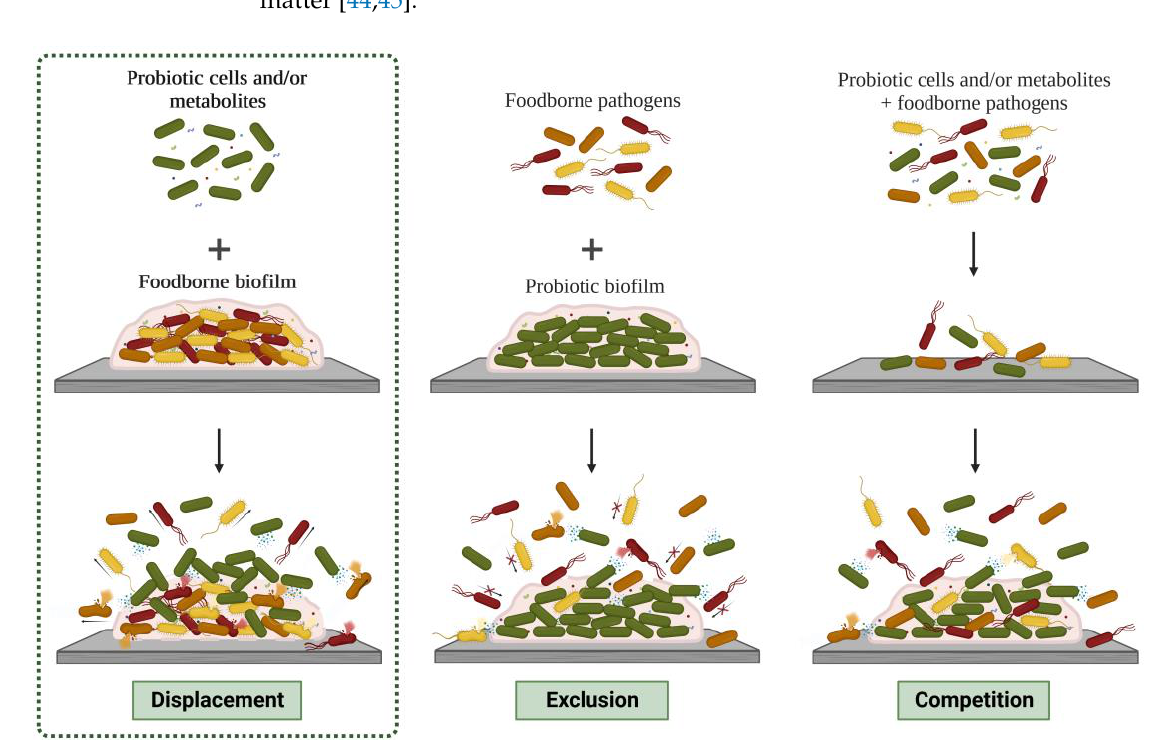
Figure 4. Schematic representation of the inhibition strategies of foodborne biofilms by probiotic cells and/or their metabolites: displacement, exclusion, and competition. This review addresses the displacement approach.